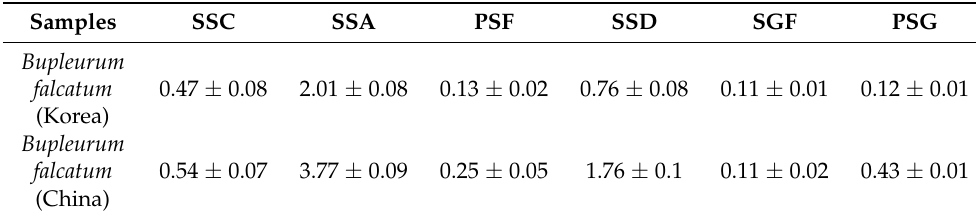
Table 2. Contents (mg/g) of six saponins in 2 batches of Bupleurum falcatum root ( n = 3).